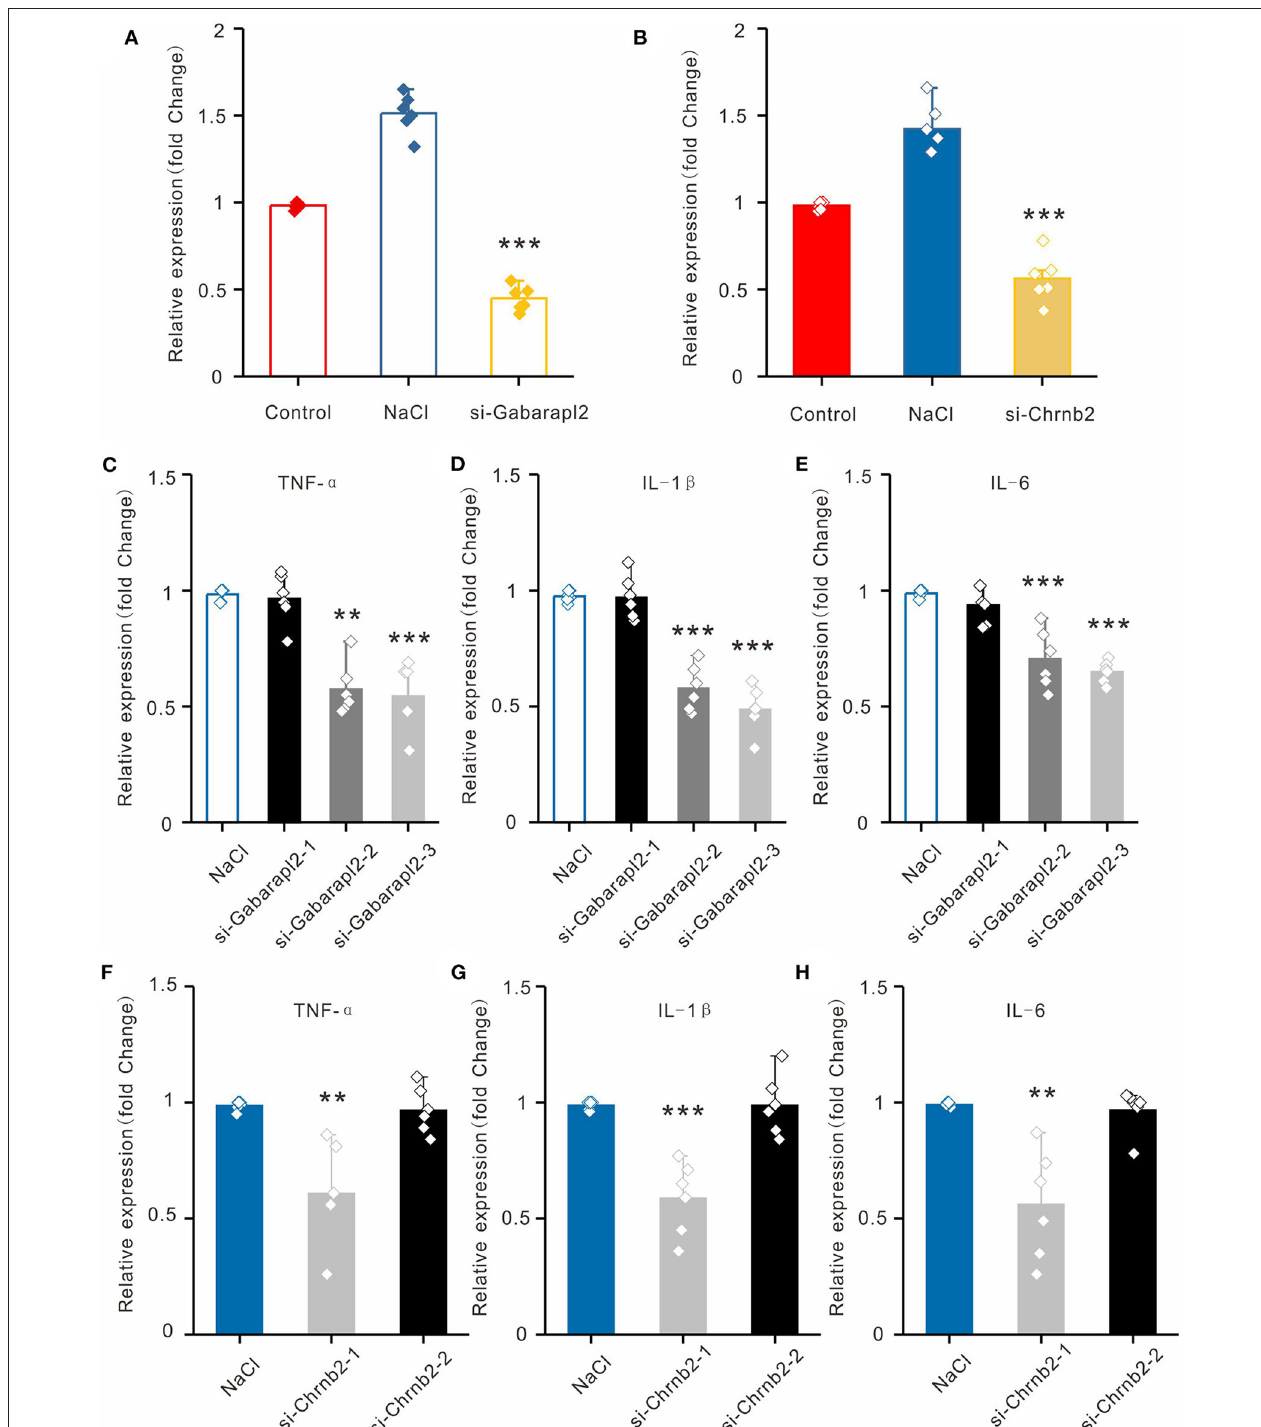
FIGURE 5 | Validation of lncRNAs Chrnb2 and Gabarapl2, regulating the inflammatory factor in vitro . (A,B) The expression levels of Chrnb2 and Gabarapl2 in HCECs after NaCl treatment. (C–E) After transfection with si-Gabarapl2, the mRNA levels of TNF- α , IL-1 β , and IL-6 in HCECs following NaCl treatment. (F–H) After transfection with si-Chrnb2, the mRNA levels of TNF- α , IL-1 β , and IL-6 in HCECs following NaCl treatment. ** p < 0.01, *** p < 0.001.